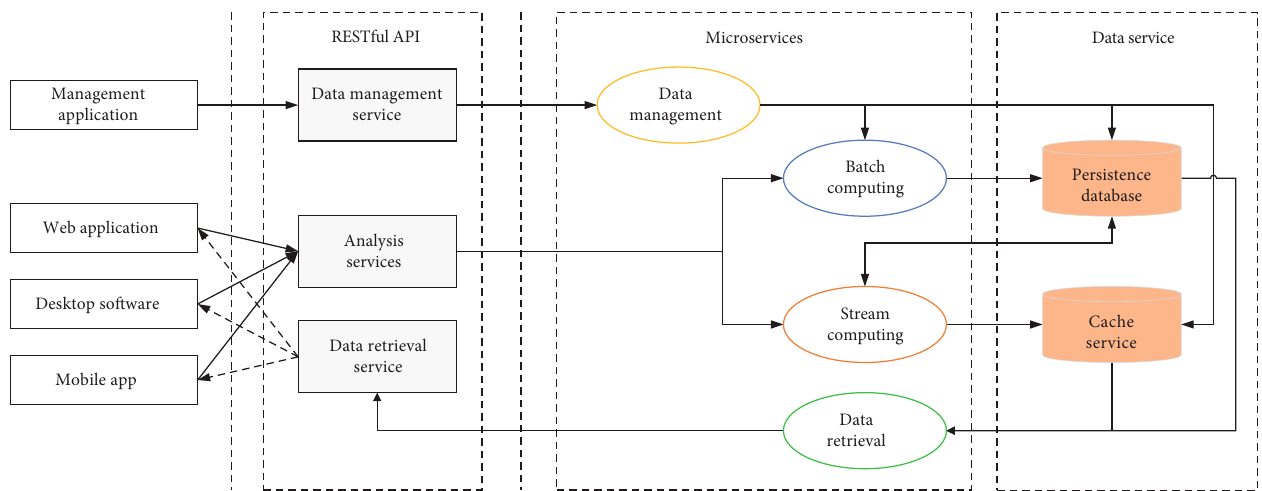
Figure 7: Data analysis architecture. In the box microservices , the data analysis and result storage are completed through the cooperation of di ff erent microservices.